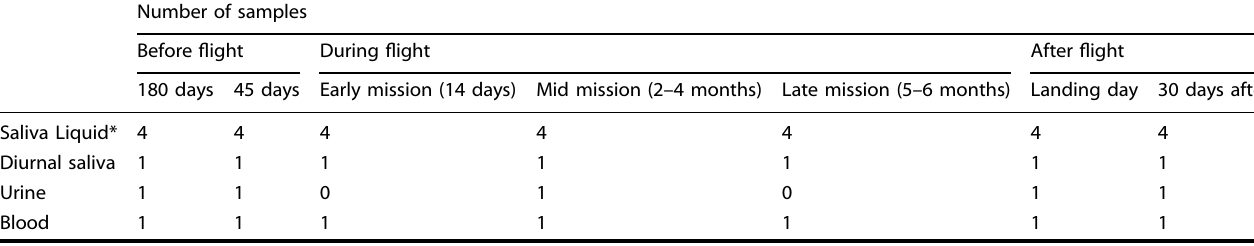
Table 3. Sample schedule for long-duration space fl ight Number of samples